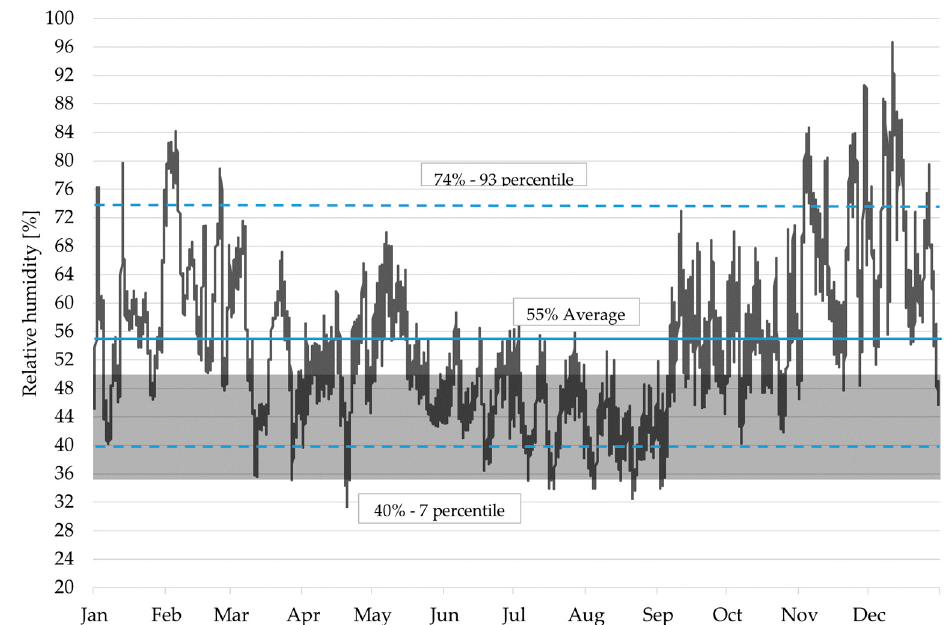
Figure 15. Trend of historic climate hourly values of RH and statistical limits of 93rd and seventh percentiles in position A vs. the range recommended by the Italian D.M. 10.05.2001 [16] (gray band).